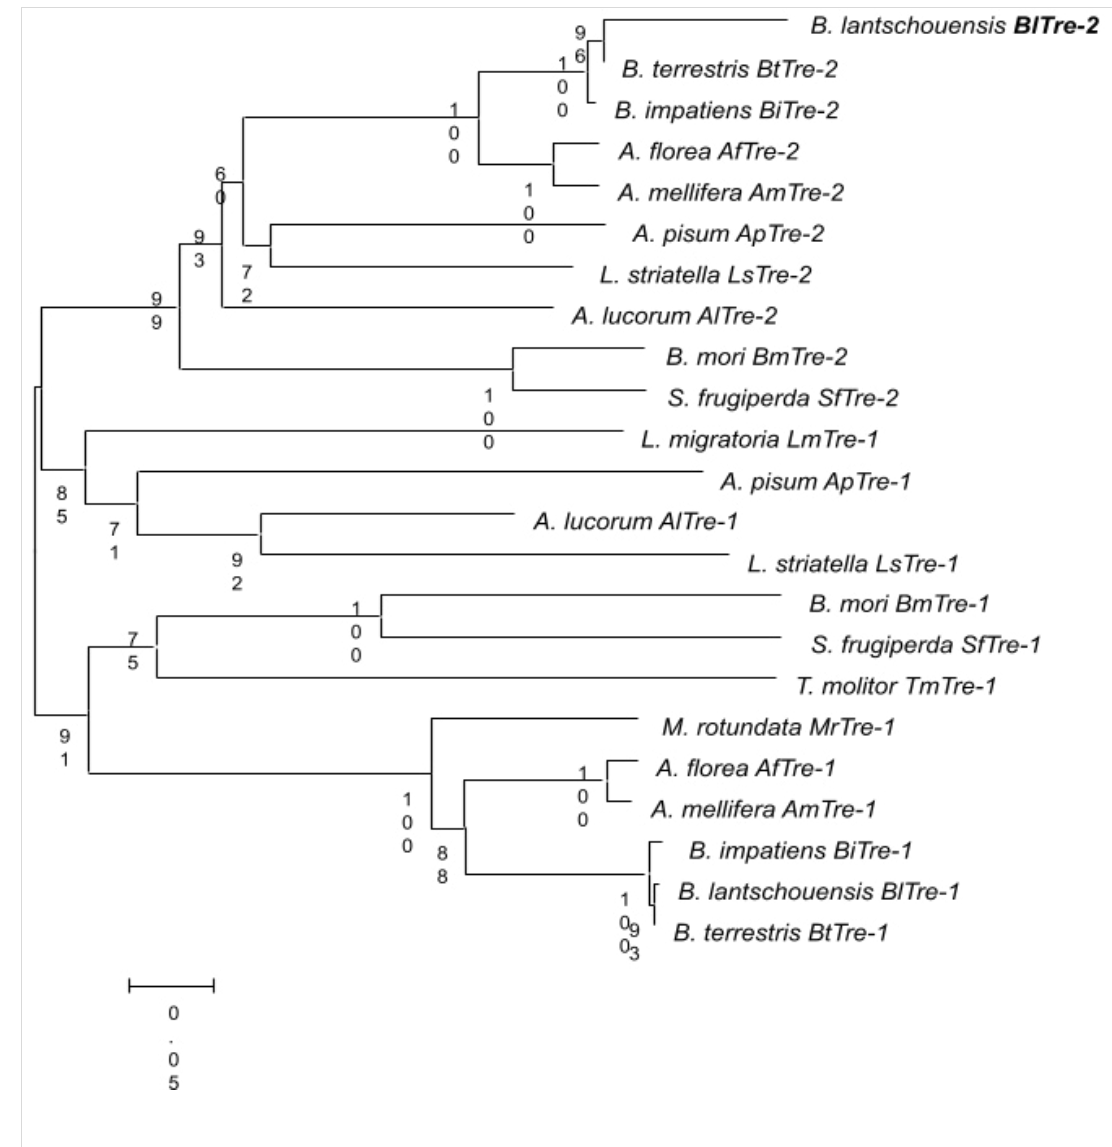
Fig 3 . Phylogenetic analysis of trehalase amino acid sequences from various species. B. lantschouensis ( BlTre-1 : KJ025078); B.